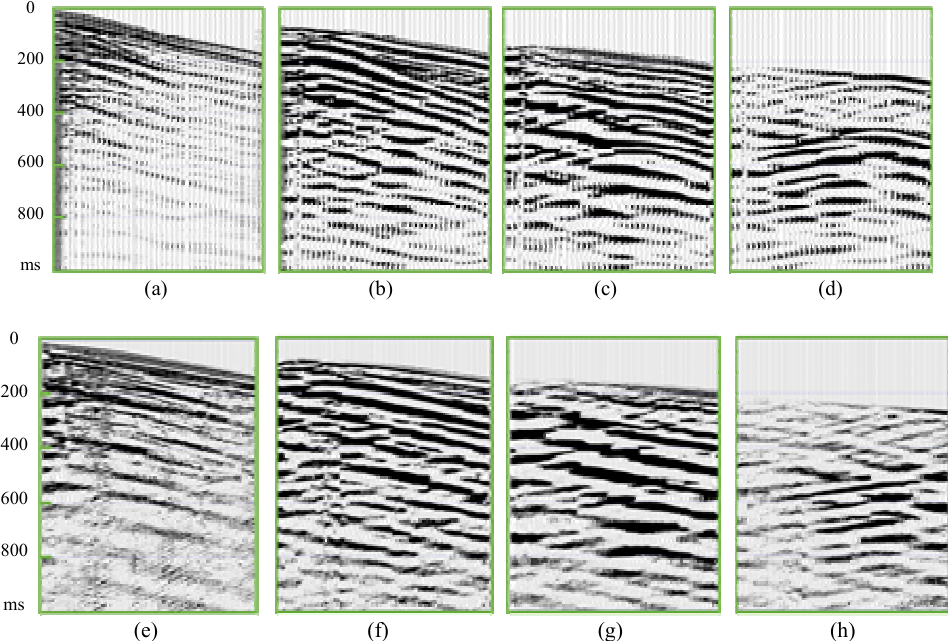
Fig. 28 Shot point data of geophone array at offsets of (a) 100 m; (b) 305 m; (c) 662 m; (d) 984 m and the uDAS system at offsets of (e) 100 m; (f) 305 m; (g) 662 m; (h) 984